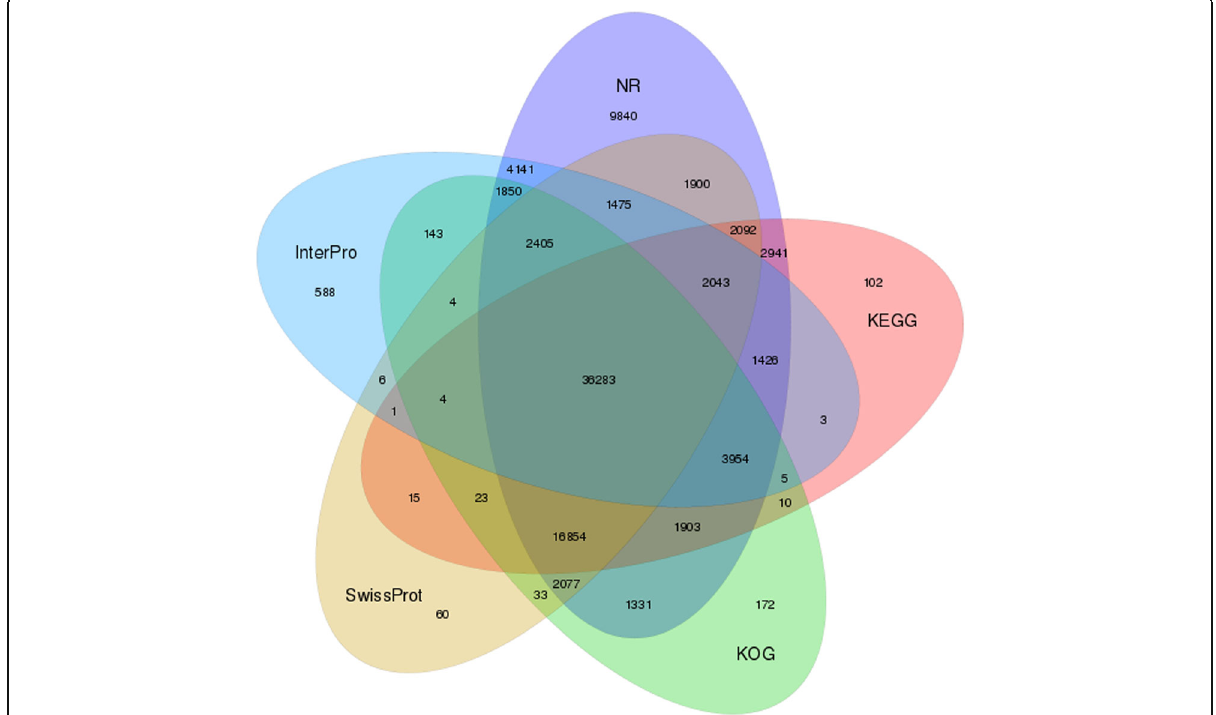
Fig. 3 Venn diagram showing all coding sequences using three software packages (CPC, txCDsPredict, and CNCI), as well as a protein database (Pfam)